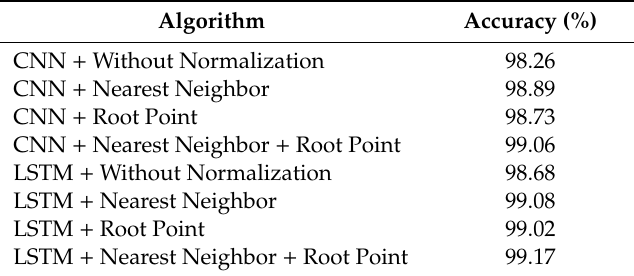
Table 2. Performance Evaluation for LSTM and CNN Model.